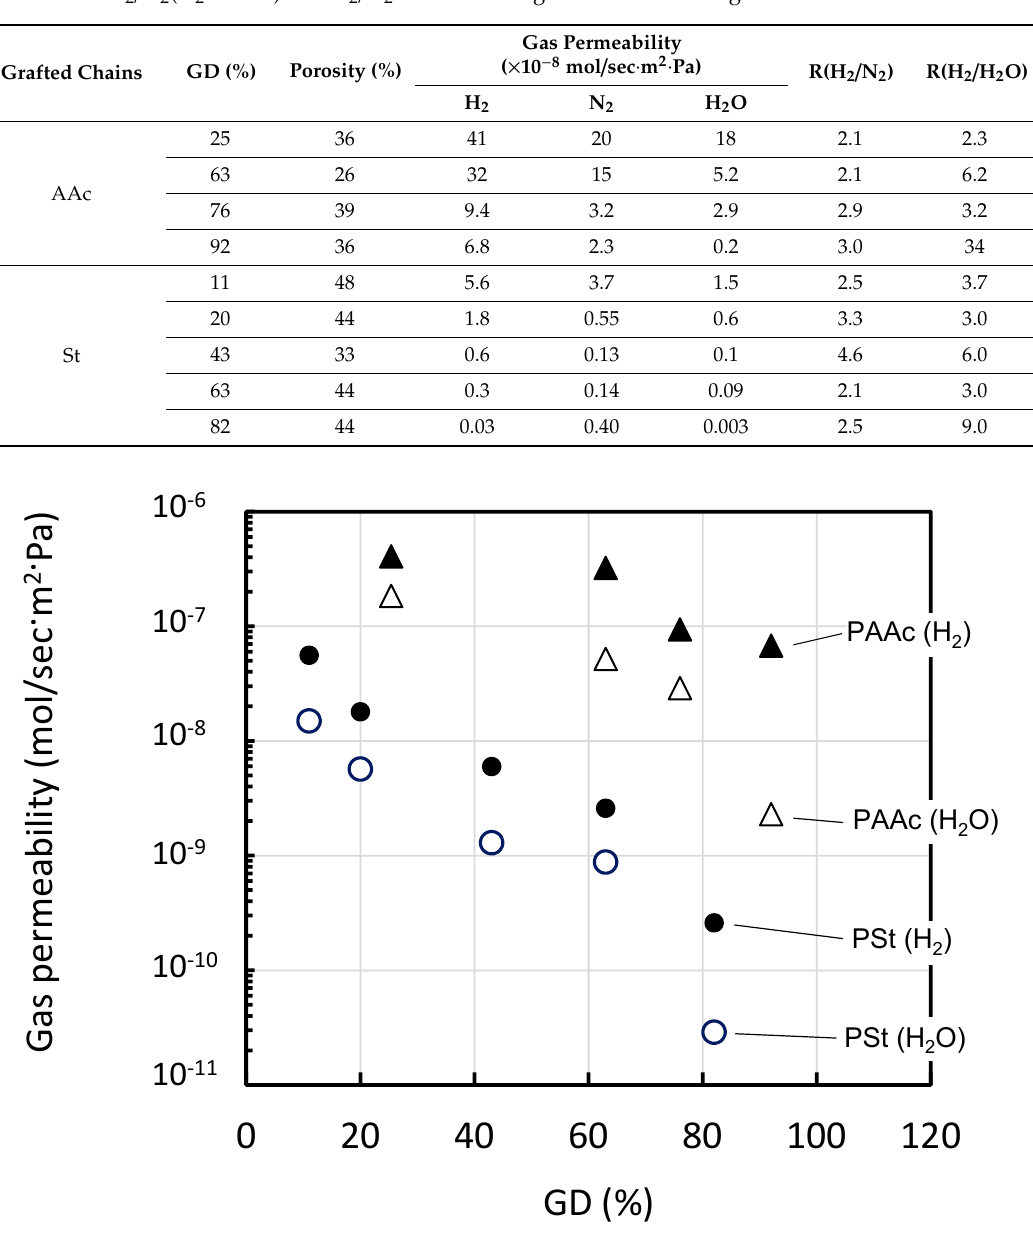
Table 2. H 2 / N 2 (O 2 model) and H 2 / H 2 O ratios through the St- and AAc-grafted PVDF membranes.